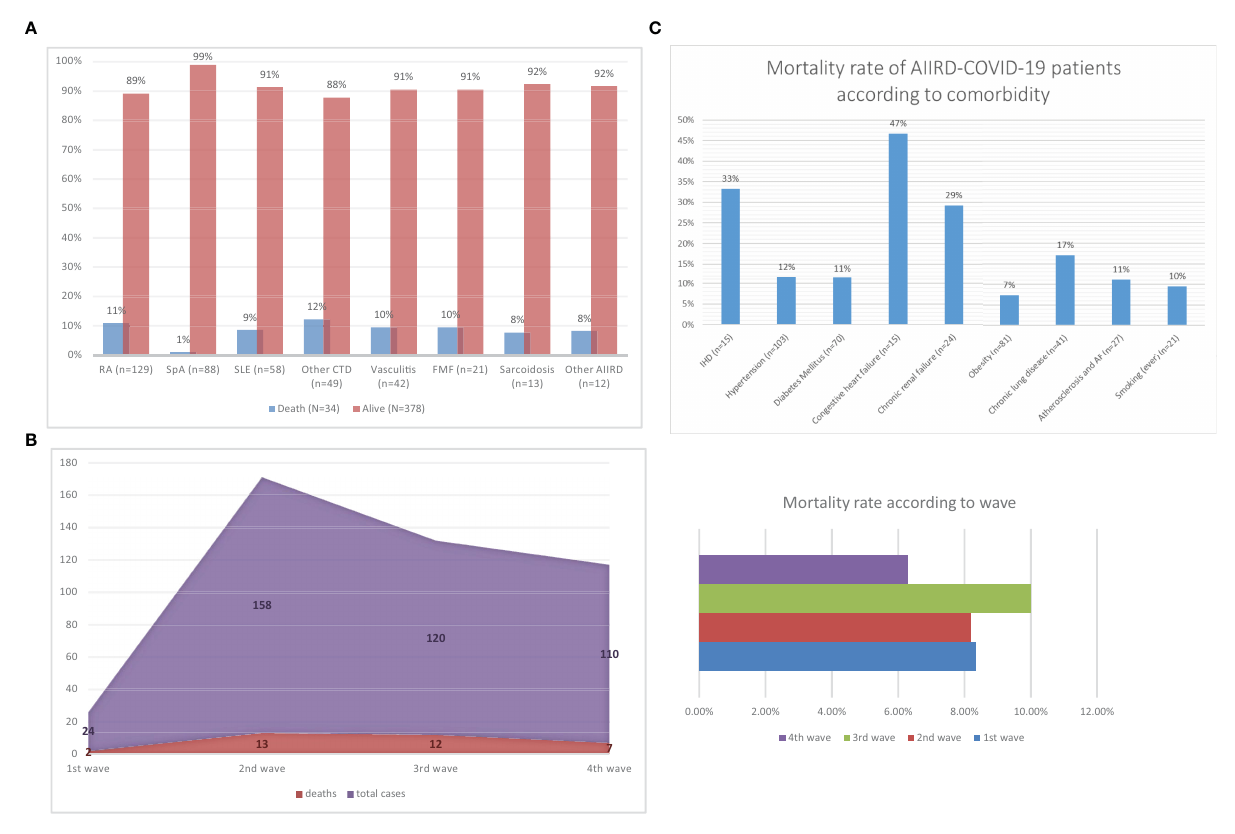
FIGURE 1 Mortality rate from COVID-19 according to AIIRD diagnosis, outbreak and comorbidities. 2 (A) Mortality rate according to AIIRD diagnosis. COVID- 19, coronavirus disease 2019; AIIRD, autoimmune in fl ammatory rheumatic disease; n, number; RA, rheumatoid arthritis; SpA, spondyloarthritis; PsA, psoriatic arthritis; AS, ankylosing spondylitis; SLE, systemic lupus erythematosus; CTD, connective tissue disease; SSc, systemic sclerosis; IIM, idiopathic in fl ammatory myopathy; MCTD, mixed connective tissue disease; FMF, familial Mediterranean fever. 2 (B) Mortality (absolute number of cases) according to COVID-19 outbreaks. COVID-19, coronavirus disease 2019. 2 (C) Mortality rate of COVID-19 according to comorbidity. AIIRD, autoimmune in fl ammatory rheumatic disease; COVID-19, coronavirus disease